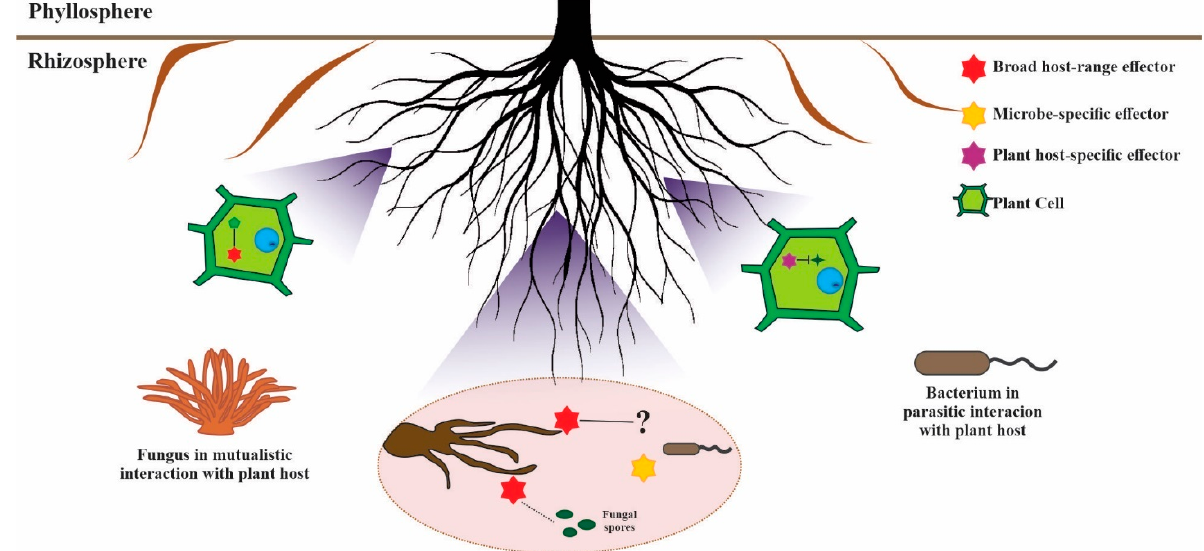
Figure 3. Effectors showing different host-range preferences based on the effector classification proposed by Snelders et al. (2018) [43]. The red effectors represent broad-host range effectors that are used by the mutualistic fungus against the plant host (far left) and against a bacterial competitor (center). It is unknown whether the red effector’s target in the bacterial competitor is the same target in the plant cell (large green icons) and the bacterium in response secretes a microbe-specific effector against the fungus (yellow effector). The purple effector represents a plant host-specific effector used by the bacterium (far right) that has an inhibitor function on the target (dark green star) in the plant cell.